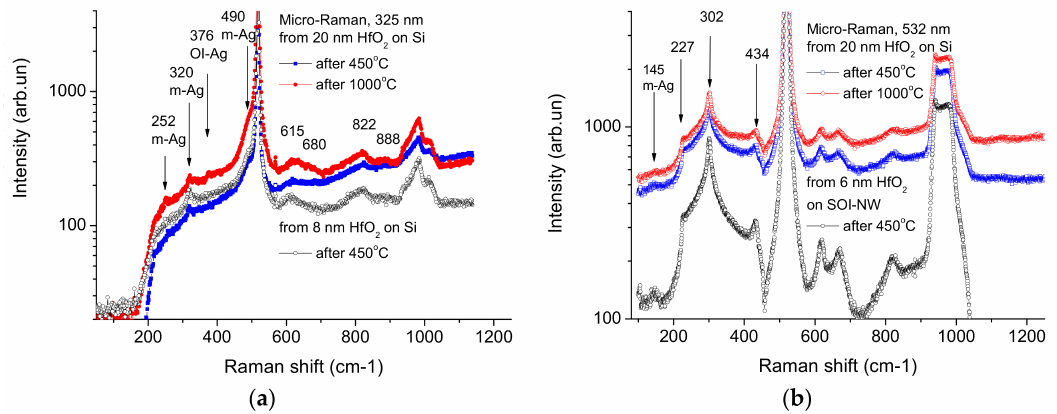
Figure 2. Typical micro-Raman spectra excited by laser radiation in ultraviolet (UV) (325 nm) ( a ) and visible (532 nm) ( b ) ranges on silicon wafers and SOI-NW chips. Experiment conditions: annealing temperature 450 ◦ C (black and blue lines) and 1000 ◦ C (red lines), HfO 2 layer thickness 20 nm (red and blue lines) and <10 nm (black lines). Arrows indicate spectrum lines corresponding to monoclinic (m) and orthorhombic (OI) phase phonons of HfO 2 ( a ) and acoustic phonons of Si ( b ) according to [35–37]).